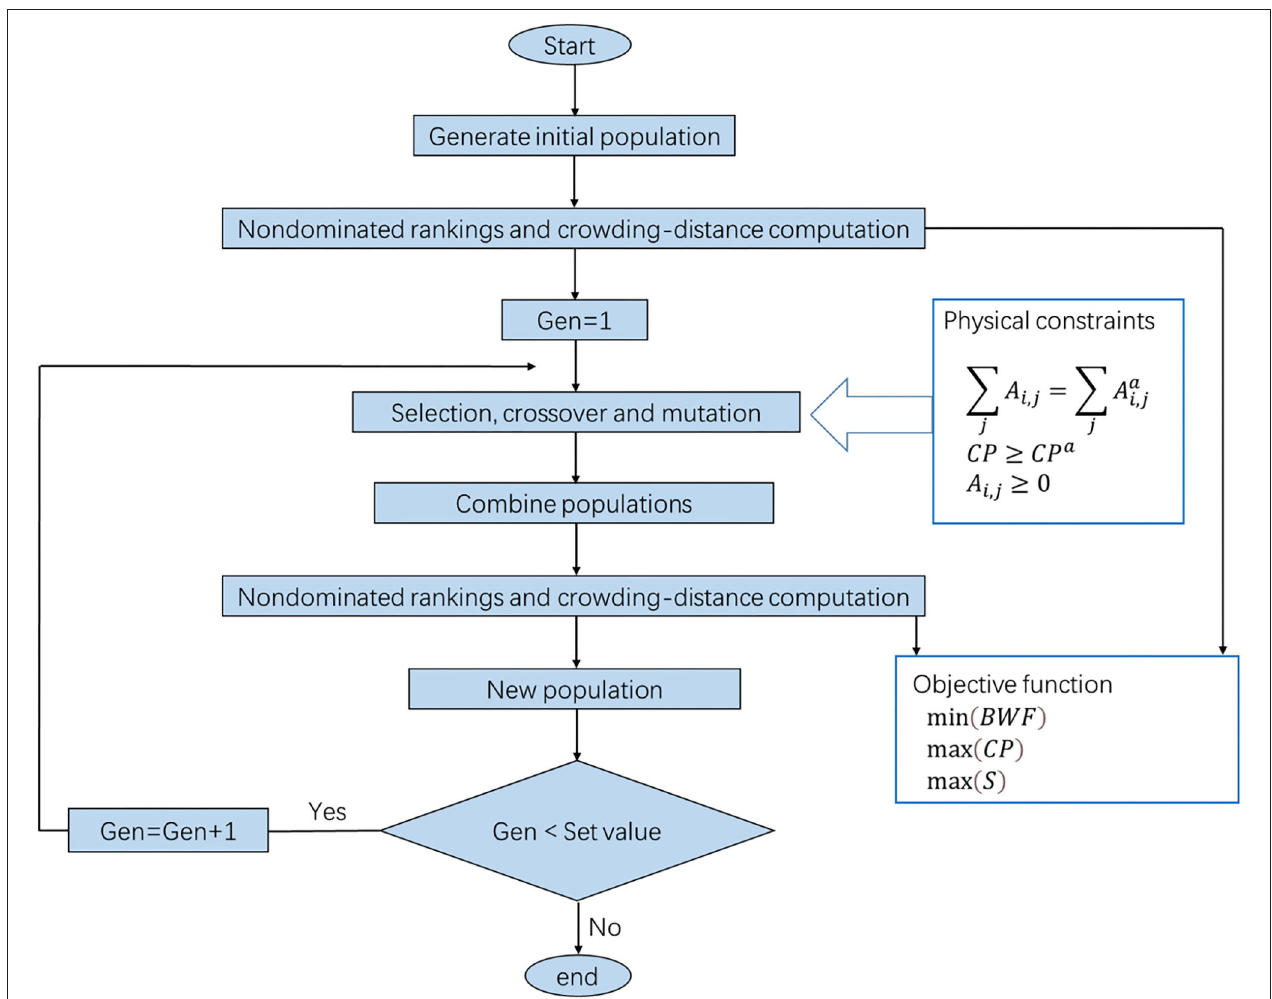
FIGURE 2 | Methodology flowchart. Each national crop planting structure represents an individual, and these different individuals form a population. By calculating the BWF, CP, and the degree of crop production no lower than the production level of reference year of everyone, the relatively optimal individual is selected as the new parent population. After iteration and evolution, it approximates the optimal